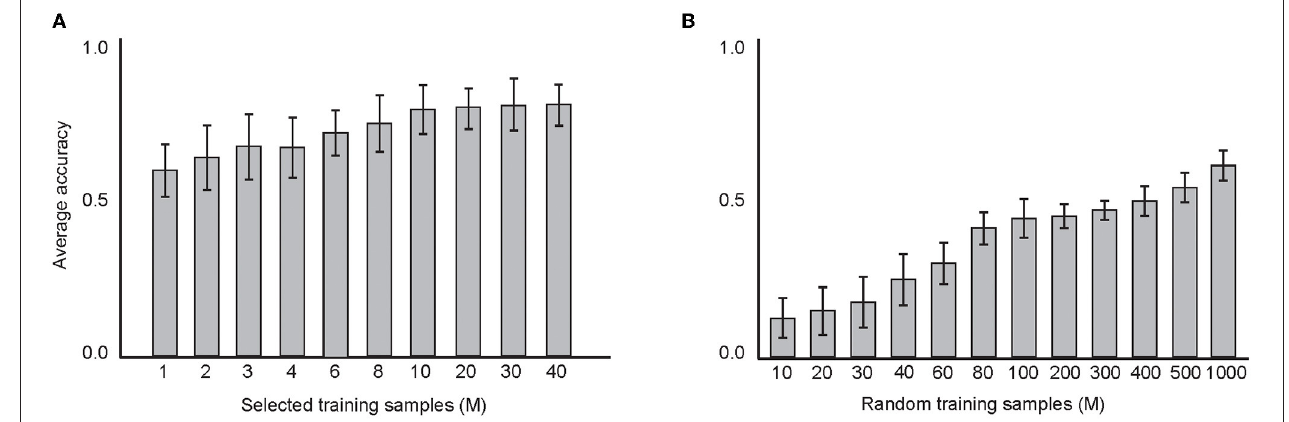
FIGURE 12 | (A) The average classification accuracy using “selected training samples per digit class.” About 1 to 40 samples from the training dataset were selected and tested on the test data. A maximum classification accuracy of the model was about 72% using 40 training samples. (B) The average classification accuracy using “random training samples per digit class. About10 to 1,000 samples from the training dataset were selected and tested on the test data. Maximum classification accuracy of the model was about 58% using 1,000 training